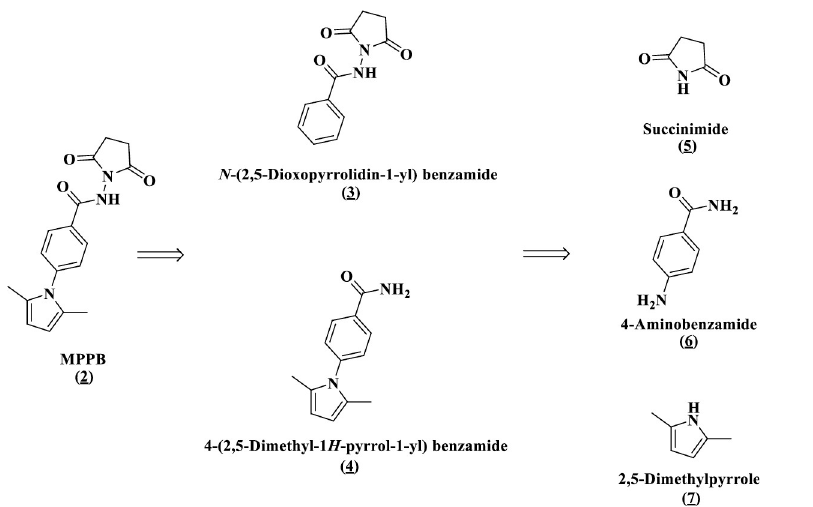
Fig 12. Five chemical components derived from